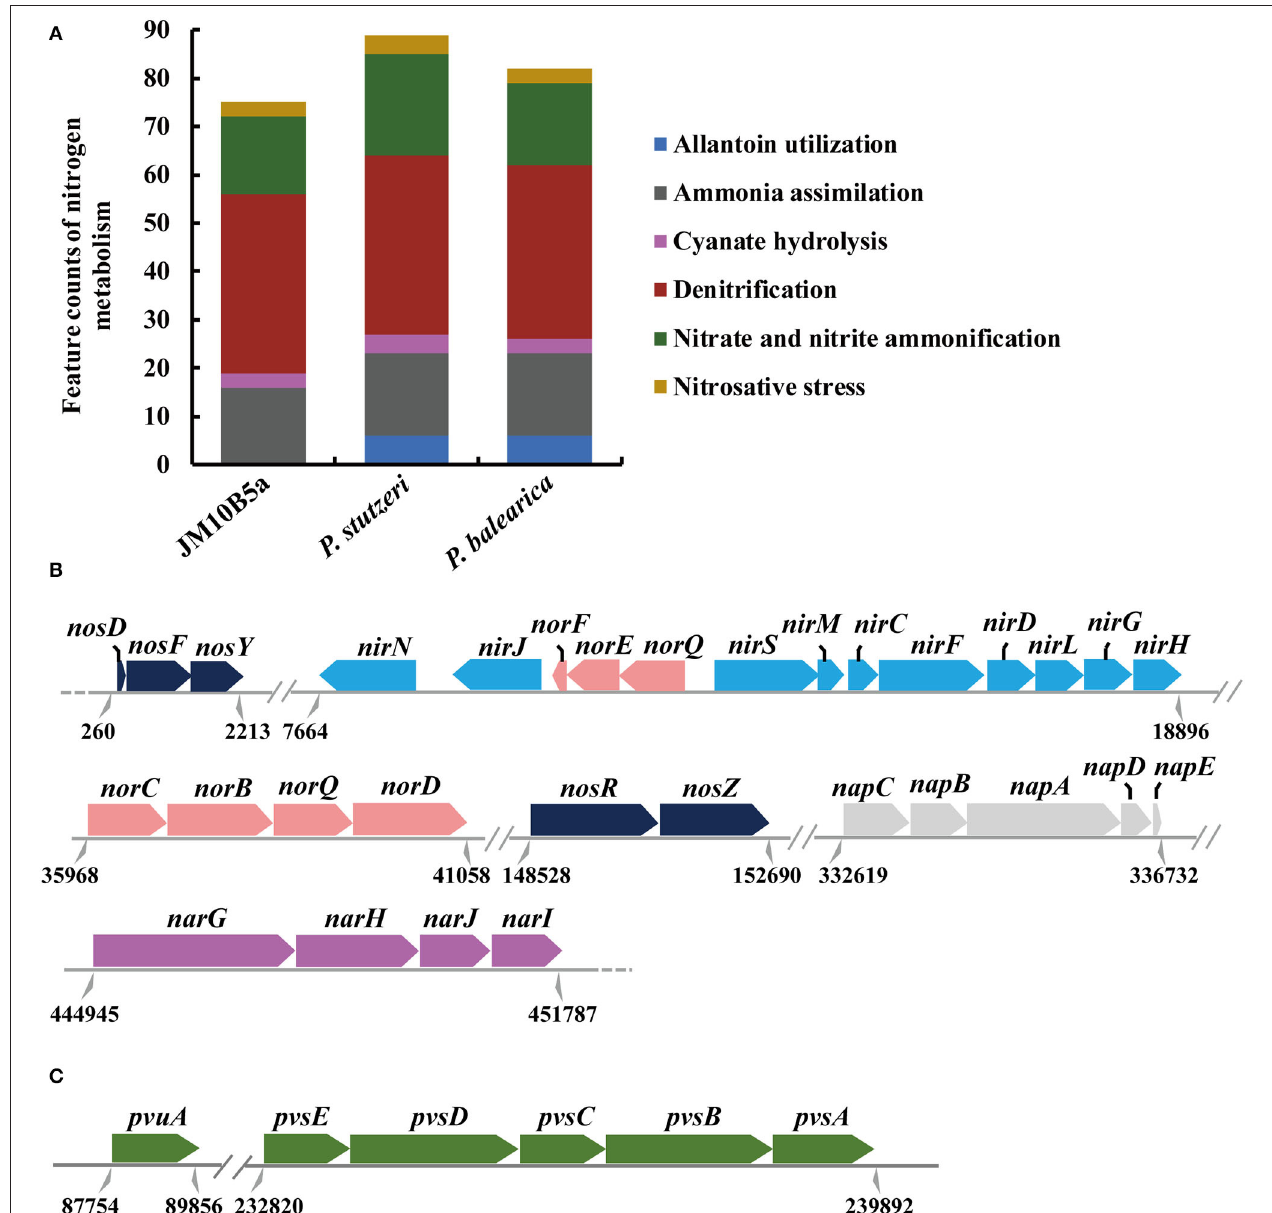
FIGURE 3 | Genomic analyses based on the RAST annotation. (A) Comparative analyses of the functional genes assigned to nitrogen metabolisms of strain JM10B5a T and the related type strains of genus Pseudomonas . (B) Relative arrangements of the denitrification genes on the draft genome of strain JM10B5a T . (C) The biosynthetic gene cluster for vibrioferrin on the draft genome of strain JM10B5a T . Parallel double lines indicate a break in locus organization among scaffolds, and dotted black lines indicate where unrelated continuity loci are not shown. Numbers below the line symbolize the locations.